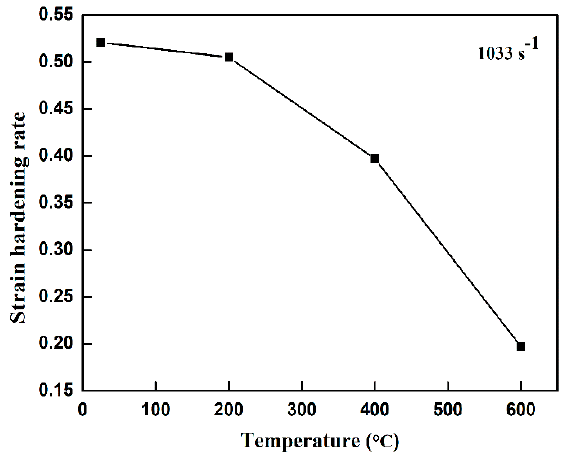
Figure 12. Strain hardening rate-temperature curve of TC18 titanium alloy.